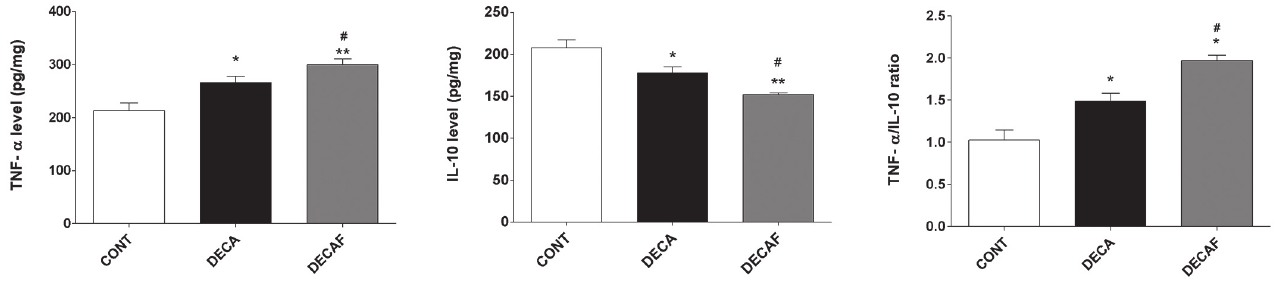
FIGURE 2 - Effects of treatment with ND in combination with finasteride on serum cytokines. Panel A: TNF-α levels were increased after cotreatment with finasteride and ND. Panel B: IL-10 levels were decreased after treatment. Panel C: Imbalance of the TNF-α/ IL-10 ratio after treatment. *p<0.05 and **p<0.01 compared to the CONT group. #p<0.05 compared to the DECA